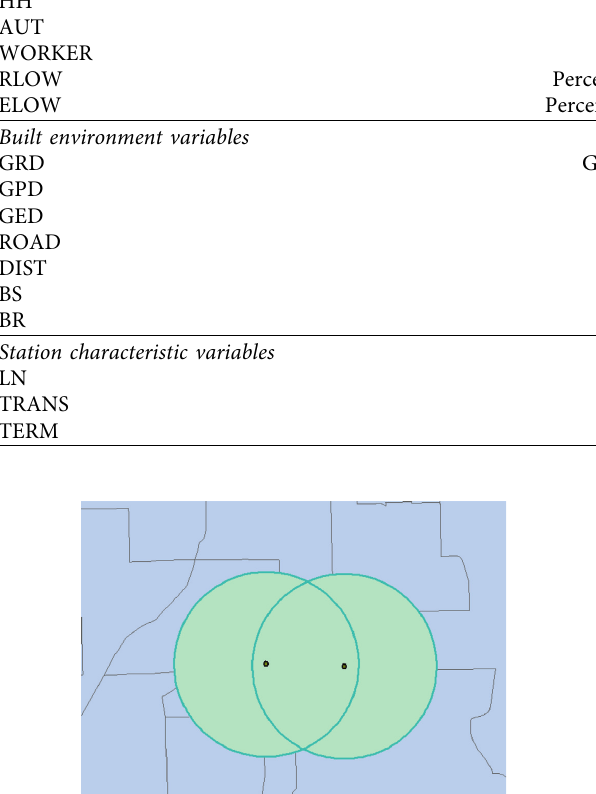
Figure 4: Overlapping area of station service coverage.